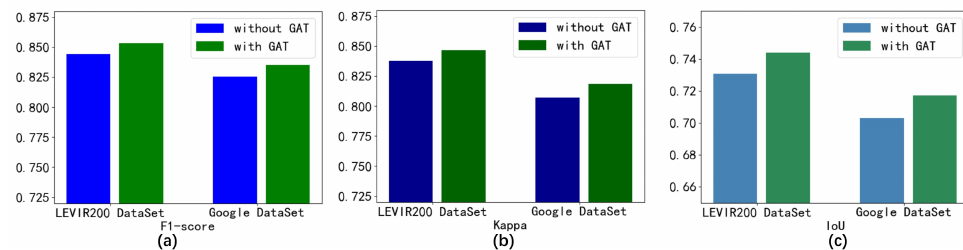
Figure 13. Effects of the GAT module. ( a ) F1-score. ( b ) Kappa. ( c )